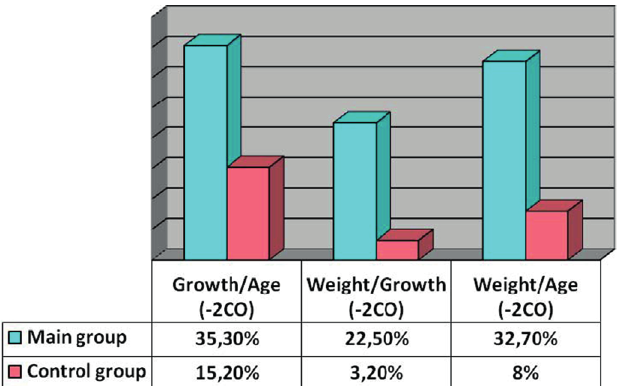
Figure 1 - A ratio of indicators of the nutritional status in the main and control